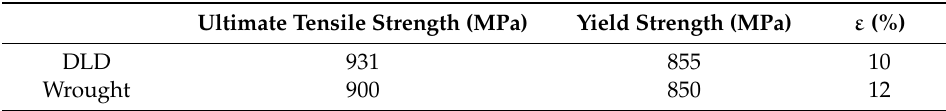
Table 4. Comparison between the tensile properties of Ti-6Al-4V produced by DED and conventional processes